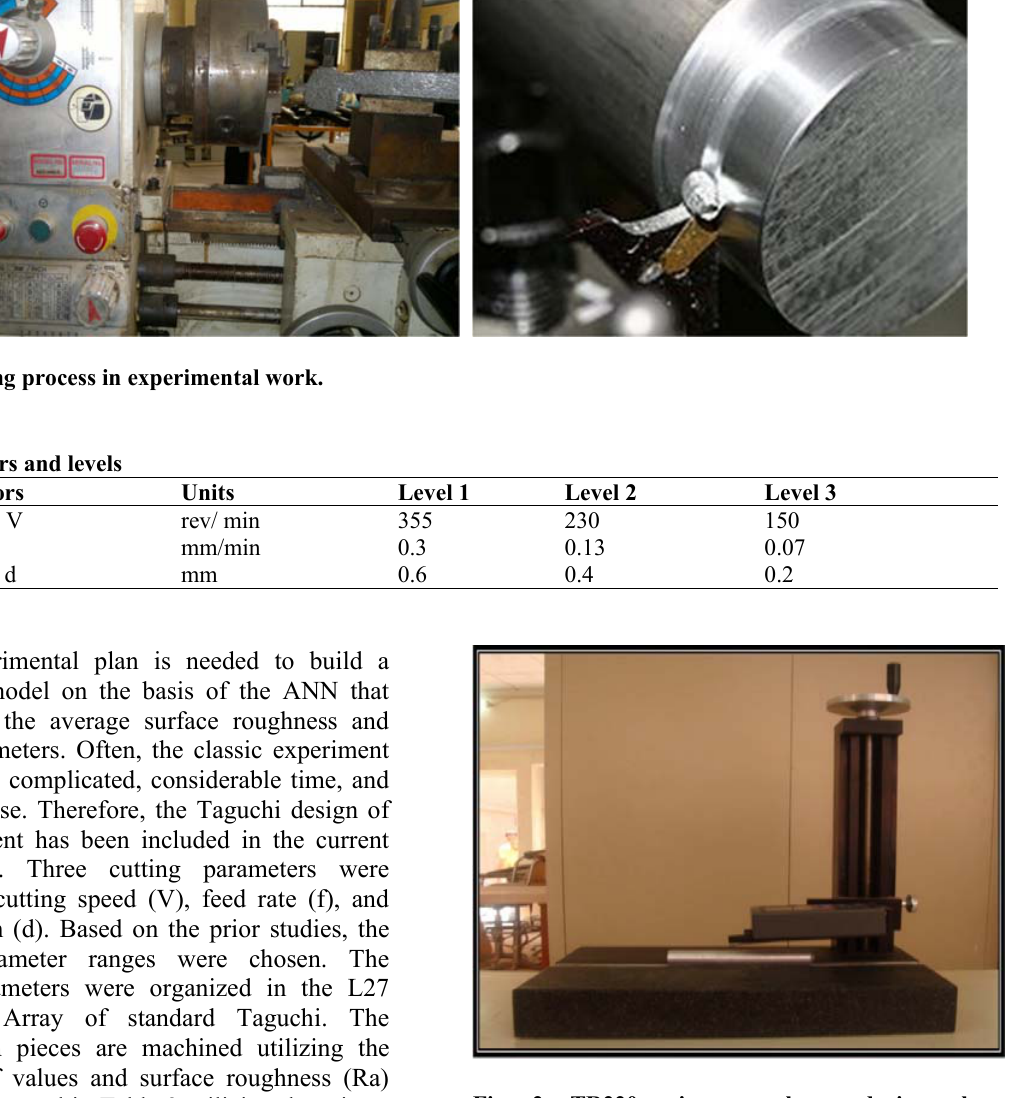
Fig. 2. TR220 micro roughness device when measuring surface